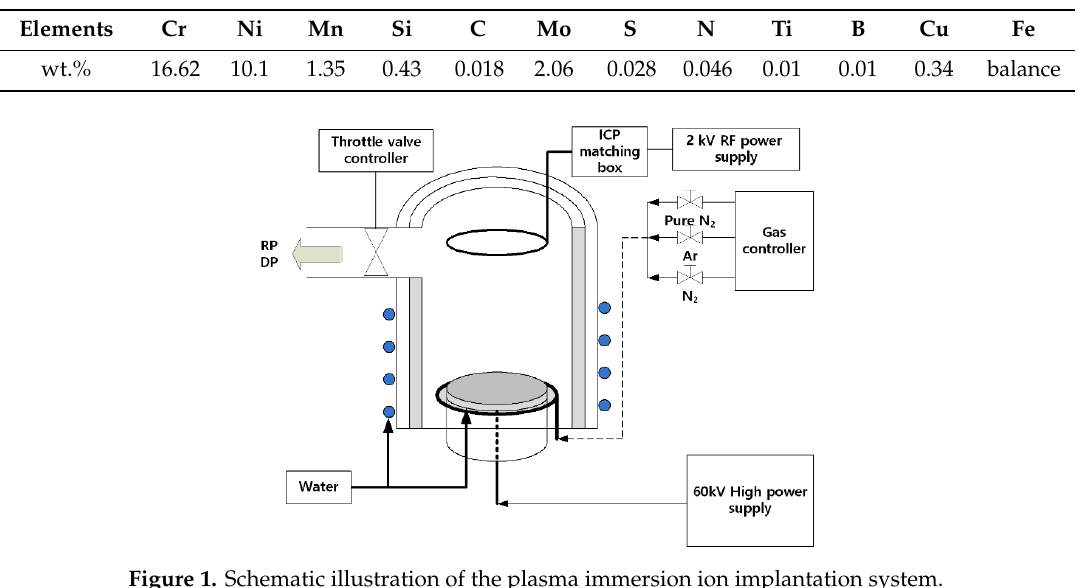
Table 1. Chemical composition of 316L stainless steel.